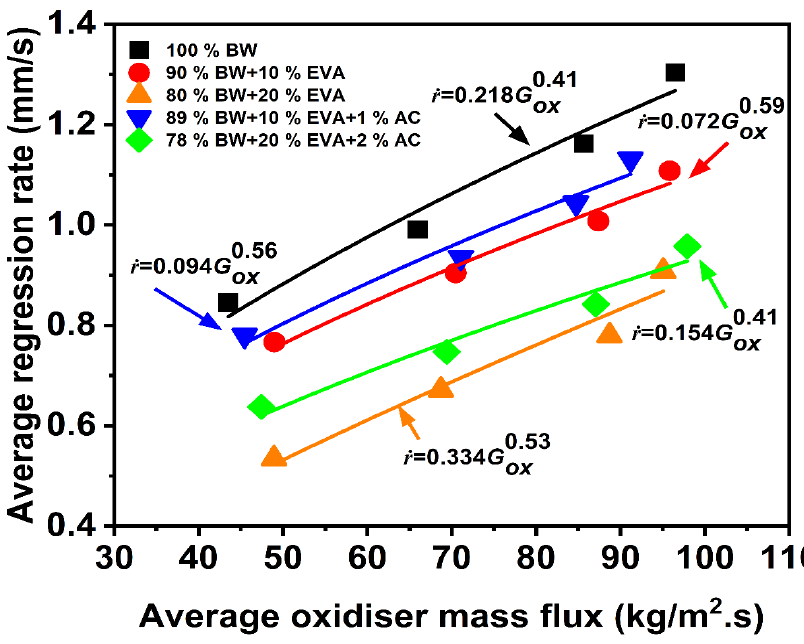
Figure 8. Average regression rate vs. oxidizer mass flux for prepared fuel grains. (Average regression rate uncertainty range: 1.2–3.5%.) Table 3. Ballistic test data for BW–EVA-based solid fuels.